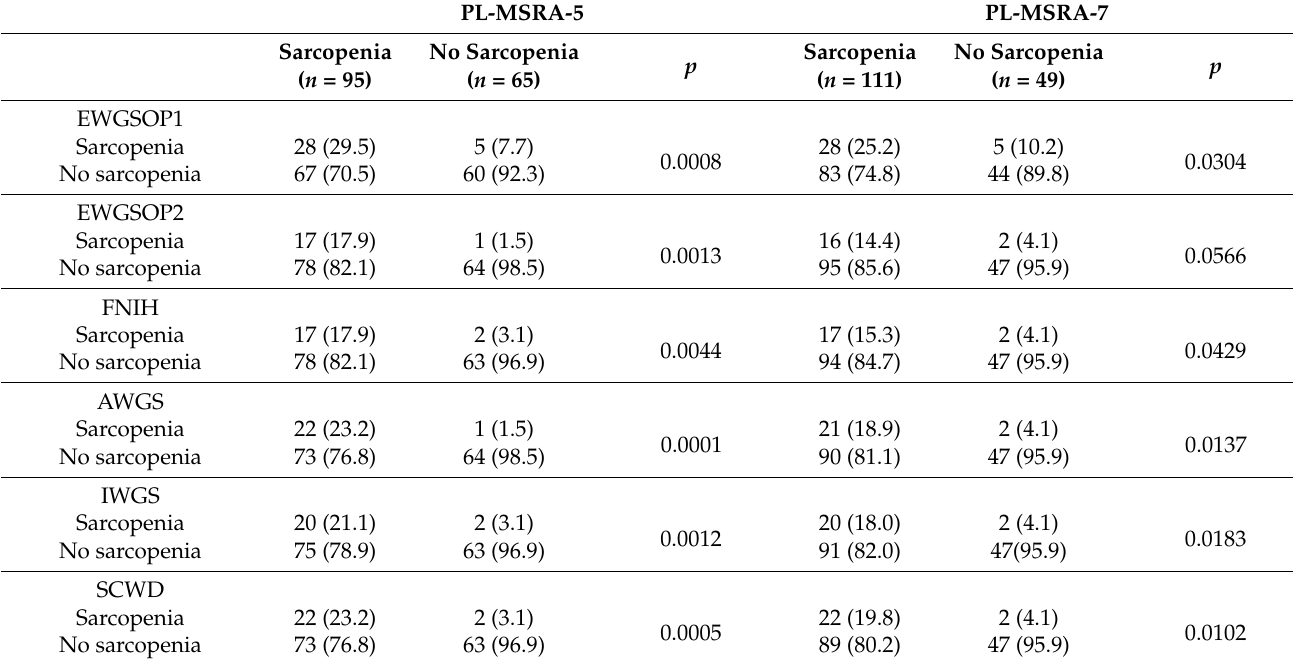
Table 5. PL-MSRA and various sarcopenia diagnostic